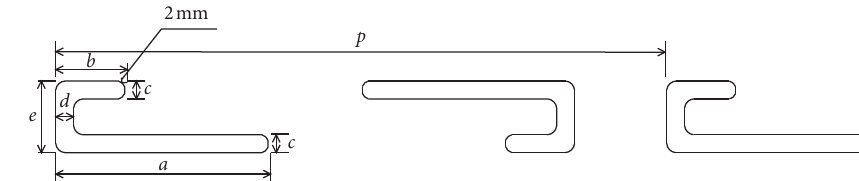
Figure 10: Diagram of the size of curved hook-groove.